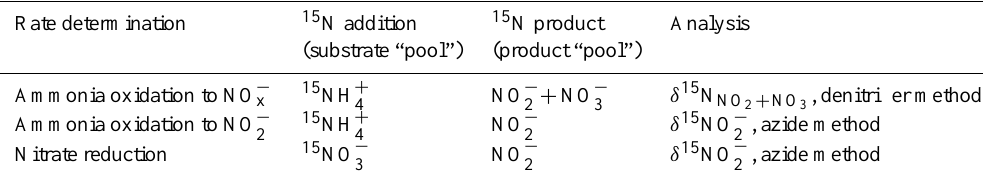
Table 1. Stable isotope tracer additions and corresponding laboratory analysis methods used in bottle incubations for geochemical rate determination. Rate determination 15 N addition 15 N product Analysis Nitrate reduction 15 NO −